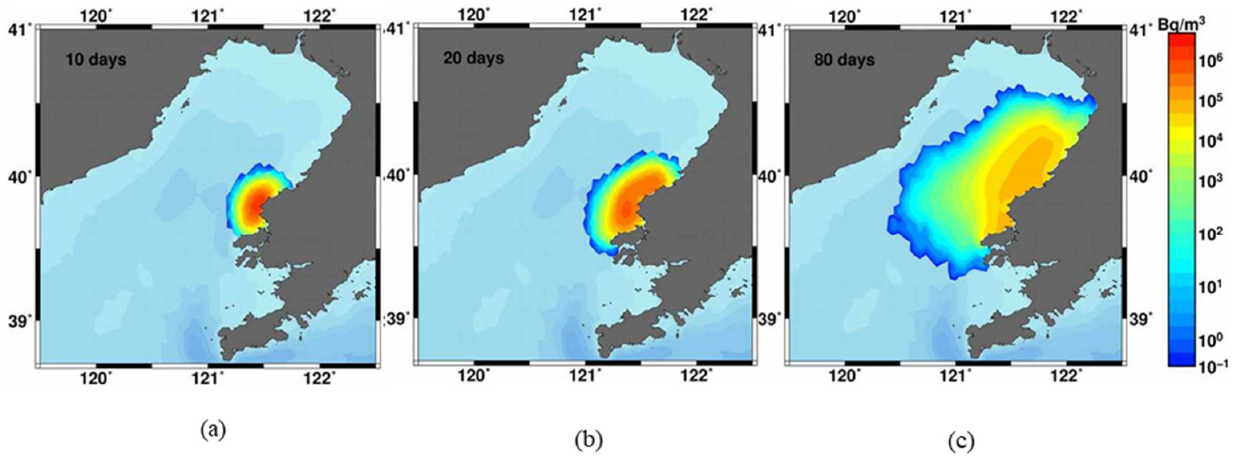
Figure 15. Surface concentration of 137 Cs after 10 days ( a ), 20 days ( b ), and 80 days ( c ) release from the Hongyanhe NPP.